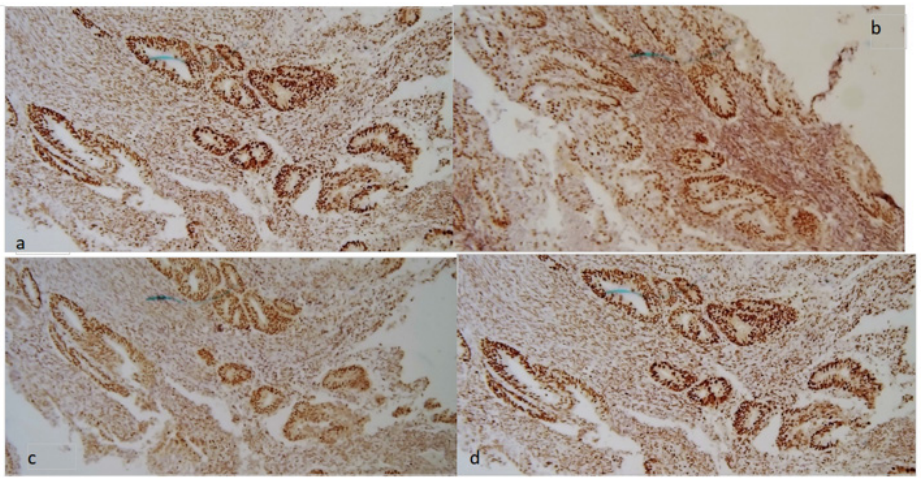
Figure 2. Tumor without MMR deficiency. Normal expression of MMR proteins: MSH2 ( a ), MSH6 ( b ), MLH1 ( c ), and PMS2 ( d ) both in neoplastic cells and in stromal cells (stained